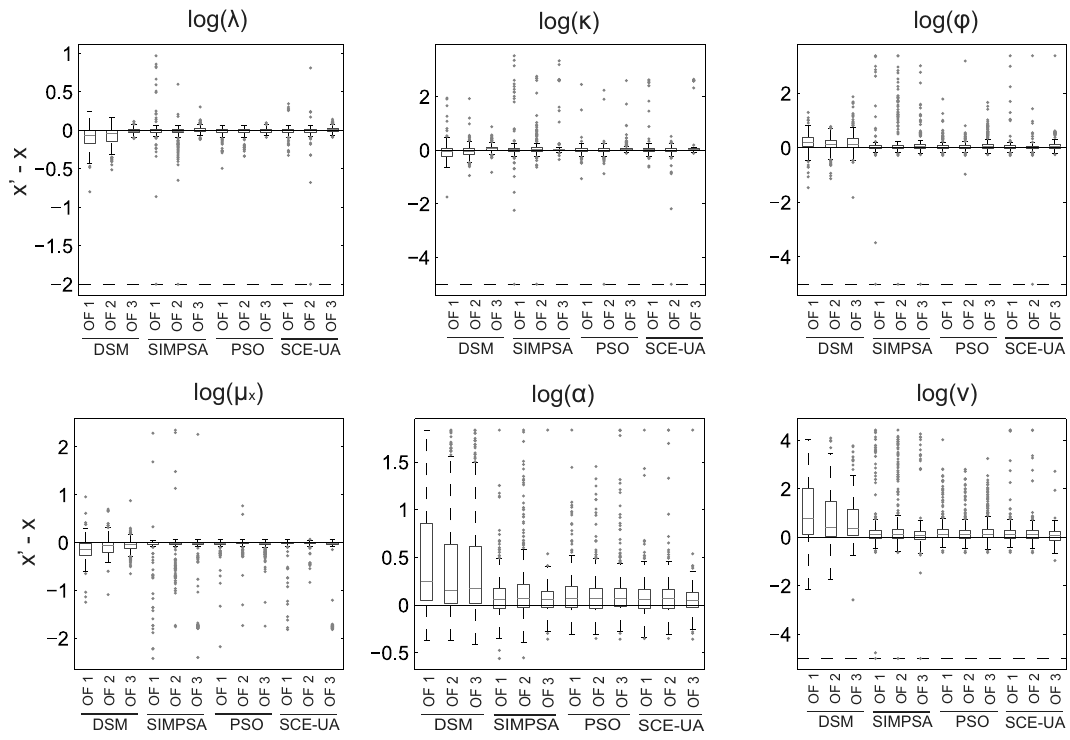
Fig. 4. Distributions of estimation error for each parameter, grouped according to the used objective Fig. 4: Distributions of estimation error for each parameter under different optimization methods and objective functions.